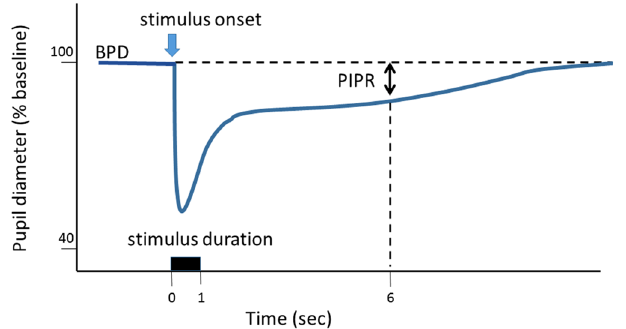
Figure 3. Parameters assessed for pupillary light response. The illustration shows the peak and sustained responses to light stimulation expected in healthy subjects. The vertical arrow indicates the stimulus onset. The duration is set as 1 s. The post-illumination pupillary response (PIPR) was determined as the value of constriction at 6 s after the light onset from baseline pupil diameter, and expressed as the % constriction from the baseline pupil diameter.